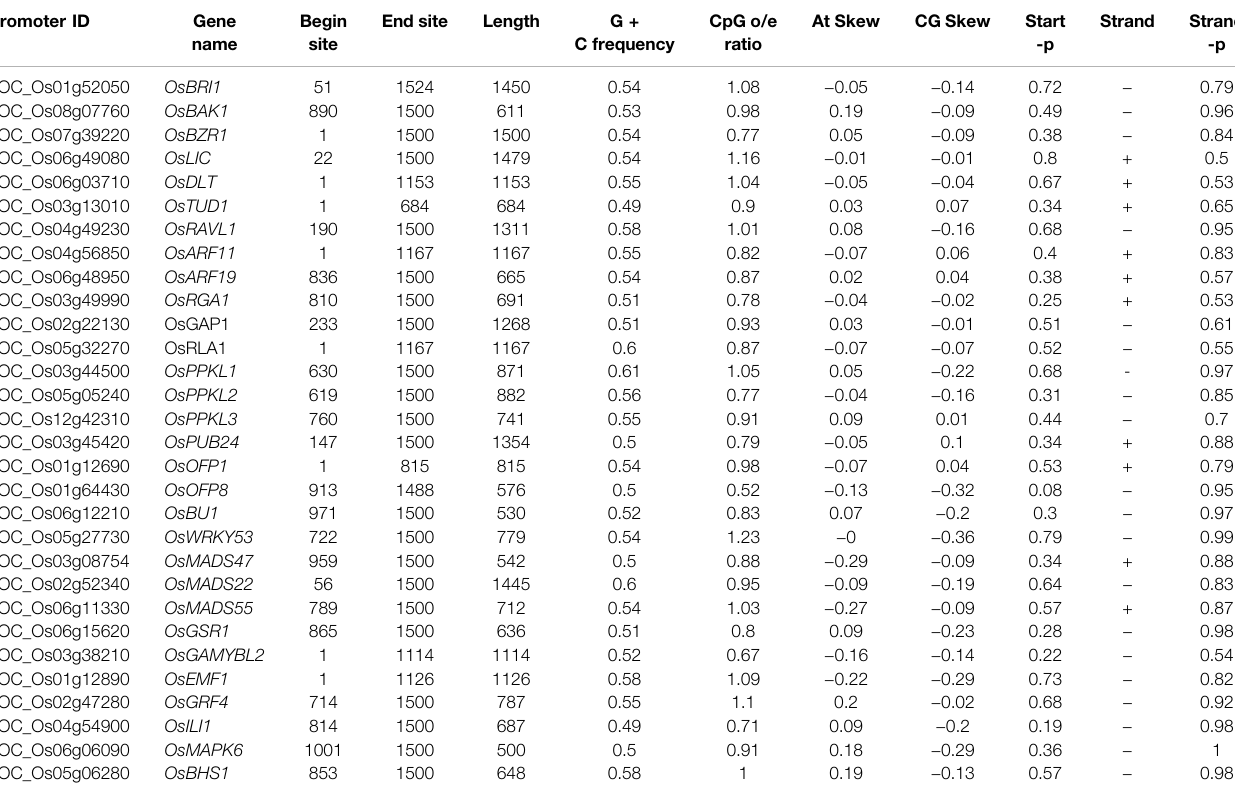
TABLE 2 | List of promoter regions of the BRs signaling-related genes containing the CpG/CpNpG motifs. Promoter